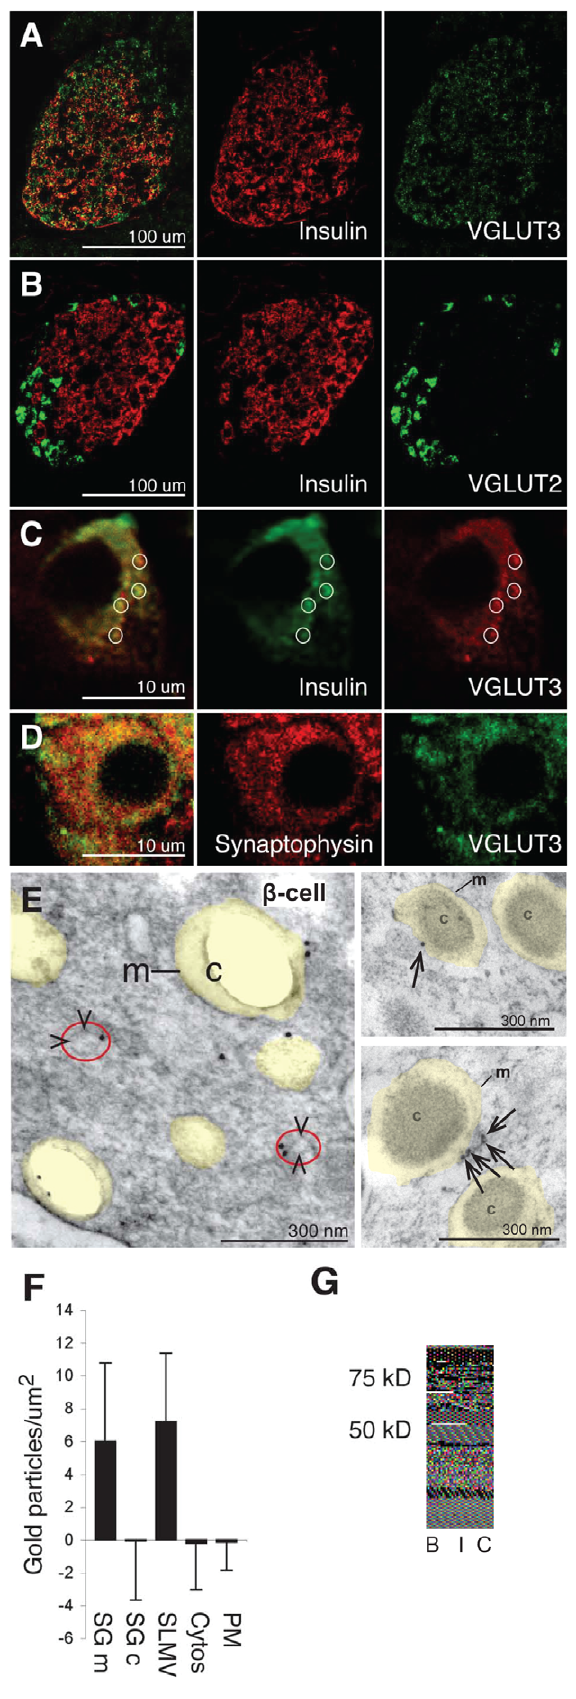
Figure 1. The vesicular glutamate transporter VGLUT3 is localized in secretory granules and synaptic-like microvesicles (SLMVs) in pancreatic b -cells. (A) VGLUT3 (green) co-localizes with insulin (red), but is also found in peripheral non-B islet cells. (B) VGLUT2 (green) does not co-localize with insulin (red). (C) A single b -cell from the islet presented in panel A: VGLUT3 (red) co-localizes partly with insulin (green). The circles highlight some of the overlapping VGLUT3 and insulin dots. (D) A single b -cell: VGLUT3 (green) co-localizes partly with synaptophysin (red) in small dots. (E) Electron micrograph showing immunogold particles for VGLUT3 in two b -cells. Secretory granules are indicated by transparent yellow. m, membranes of secretory granules. c, core of the secretory granule (of which some disappeared in the preparation procedure). SLMVs are indicated by arrowheads and red circles. (F) Quantification of VGLUT3 in b -cells (n=8 cells). Immunogold particle densities (mean number of gold particles/ m m 2 6 SD) in the membrane of the granules (SGm) and in SLMVs are significantly higher than in the core of the b -cell granules (SGc), cytosol and plasma membranes (PM) (background labeling, quantified over mitochondria, is subtracted, see Methods) (p , 0.001, Mann-Whitney-U test, two tails). (G) Western blots of rat brain tissue (B) and isolated rat islets (I) probing for VGLUT3. (C), islet blot without the VGLUT3 primary